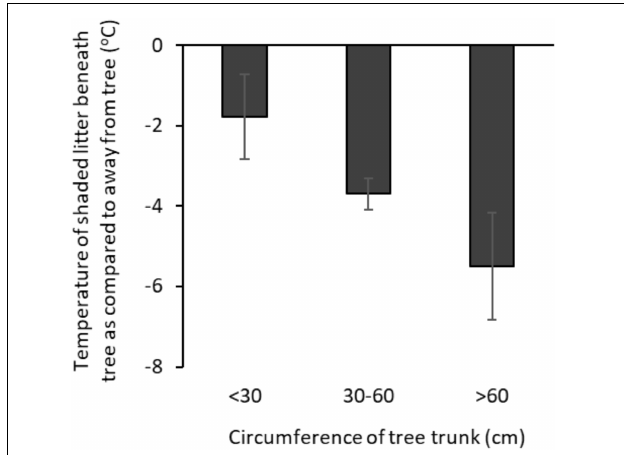
FIGURE 8 | The thermal benefit of trees: the difference between the surface temperature of shaded leaf-litter beneath a tree as compared with shaded leaf-litter > 2 m from a tree ( ◦ C), by tree size (circumference of largest trunk at 1.5 m) at mean air temperature of 39.5 ◦ C. Error bars show